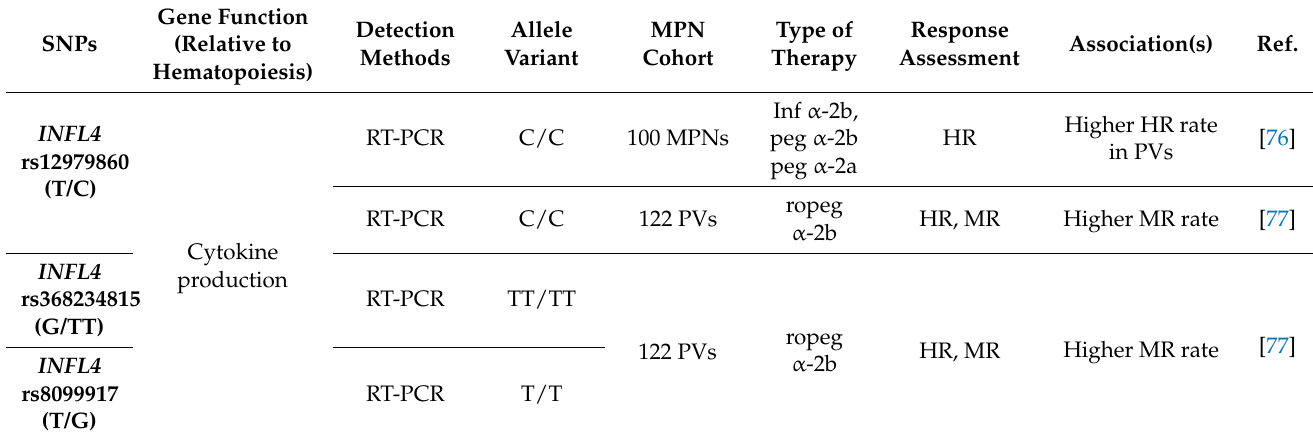
Table 3. Host genetic variants affecting response to therapy in